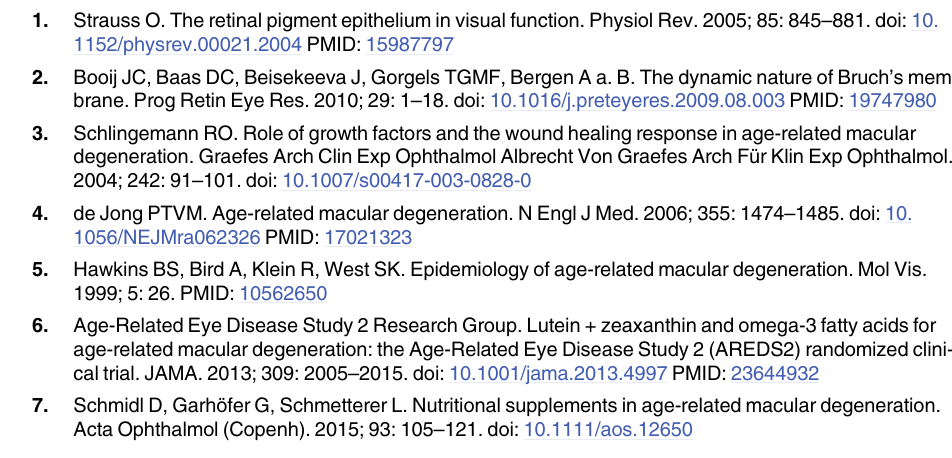
S3 Table. Molecular networks of the Mouse high RPE gene expression dataset. S4 Table. Molecular networks of the Human high RPE gene expression dataset. S5 Table. Molecular networks of the Mouse and Human high RPE gene expression dataset in Webgestalt. S6 Table. 101 genes highly expressed in mouse RPE but hardly in human RPE. S7 Table. Molecular networks of the 101 genes highly expressed in mouse RPE but hardly in human RPE. S8 Table. Molecular networks of the 101 genes highly expressed in mouse RPE but hardly in human RPE in Webgestalt. S9 Table. 54 genes highly expressed in human RPE but hardly in mouse RPE. S10 Table. Molecular networks of the 54 genes highly expressed in human RPE but hardly in mouse RPE. S11 Table. Molecular networks of the 54 genes highly expressed in human RPE but hardly in mouse RPE in